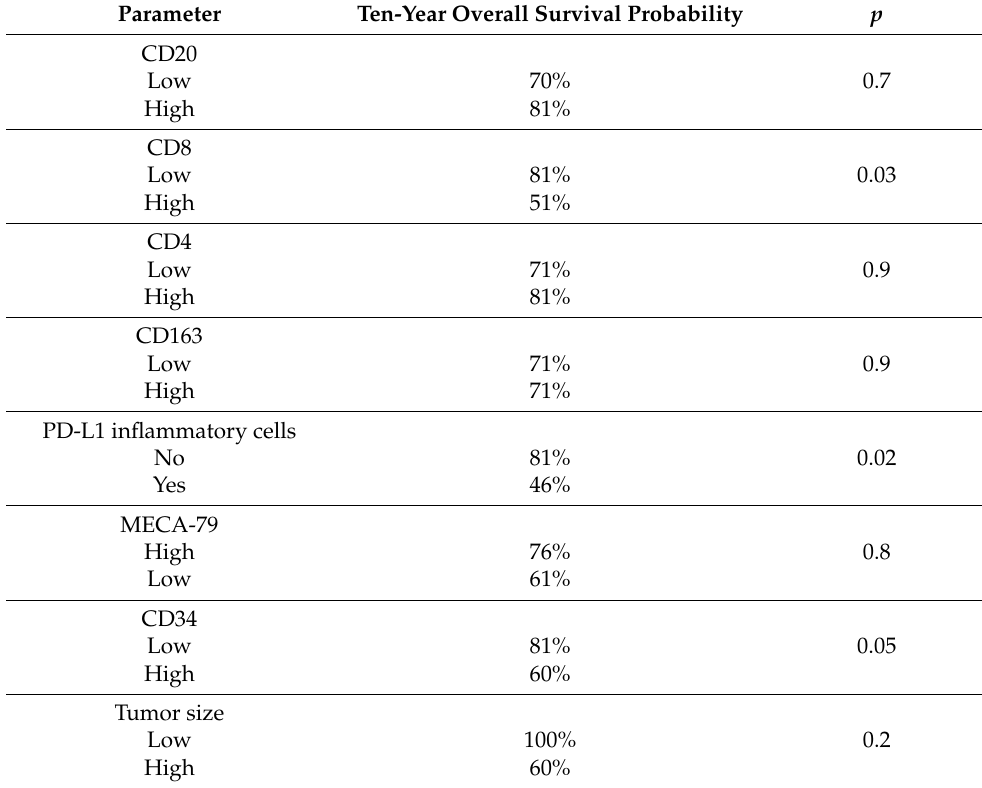
Table 4. Kaplan–Meier survival